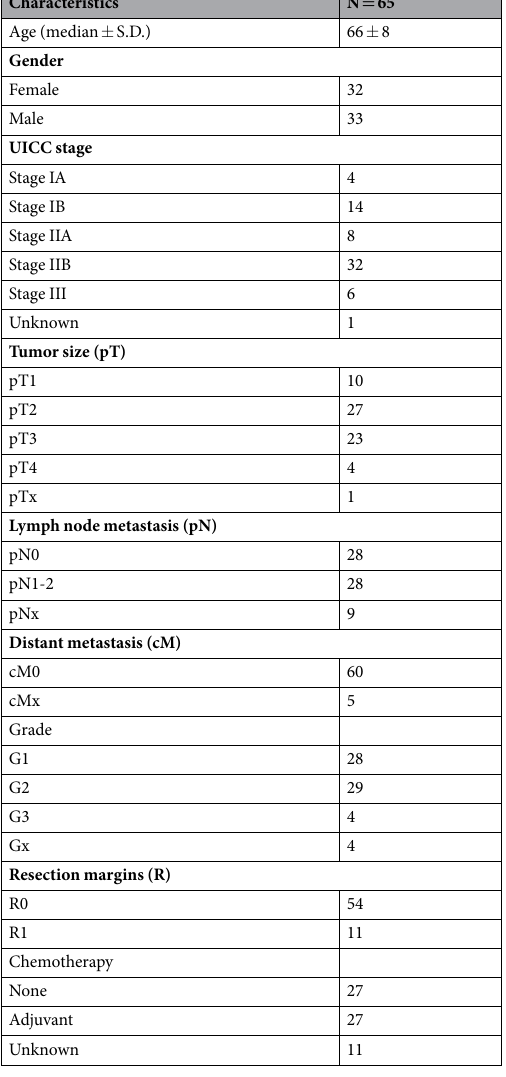
Table 1. Clinical data of patients included in this